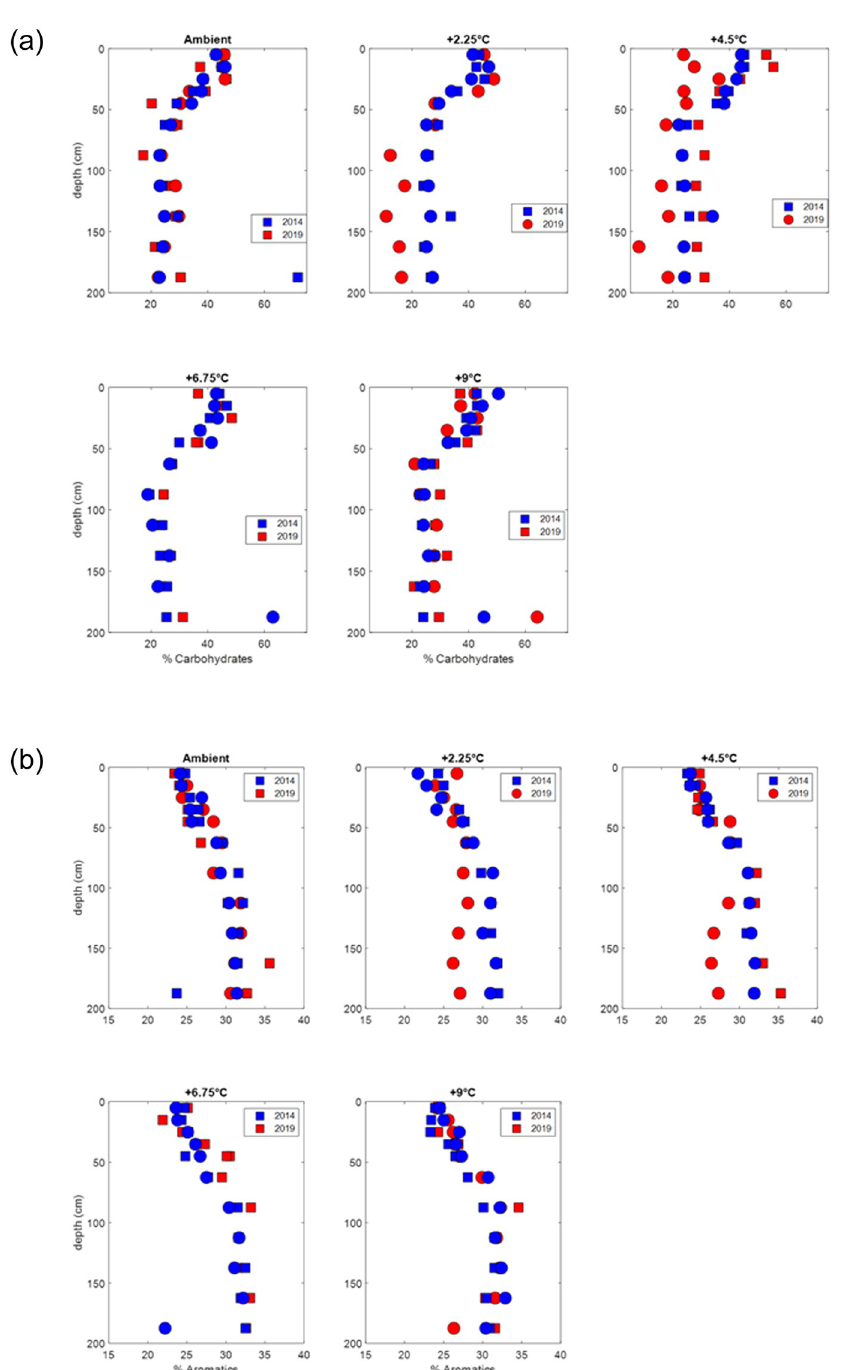
Fig 3. Carbohydrate and aromatic content versus depth. Carbohydrate content in peat cores taken from each temperature treatment in duplicate heated enclosures (two cores per temperature treatment) from the beginning of deep peat heating (2014) and after 5 years of warming (2019) (upper panel). Lower panel, aromatic content. Circles are the ambient CO 2 and squares are the elevated CO 2